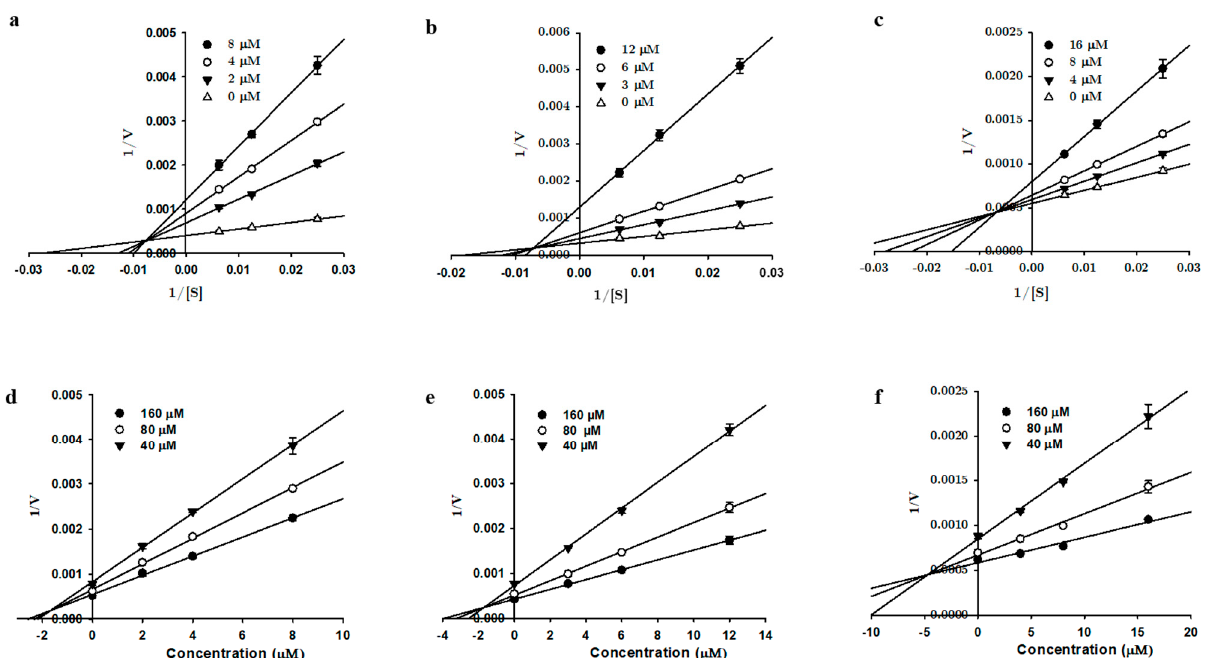
Figure 2. Lineweaver-Burk ( a − c ) and Dixon ( d − f ) plots of tanshinone I, tanshinone IIA, and cryptotanshinone for hMAO-A inhibition, respectively.